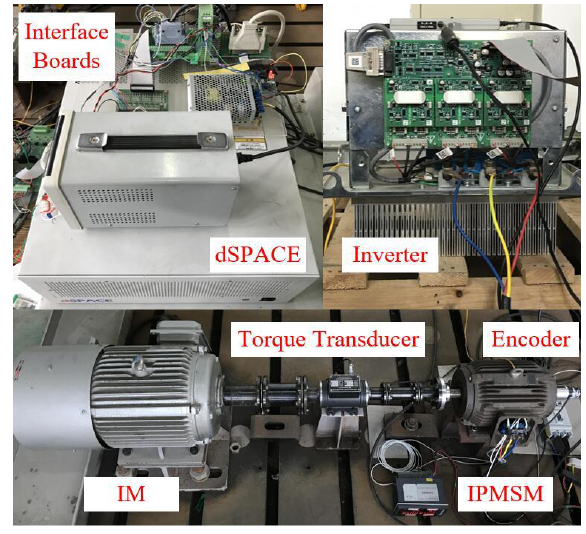
Figure 2. Experimental setup.